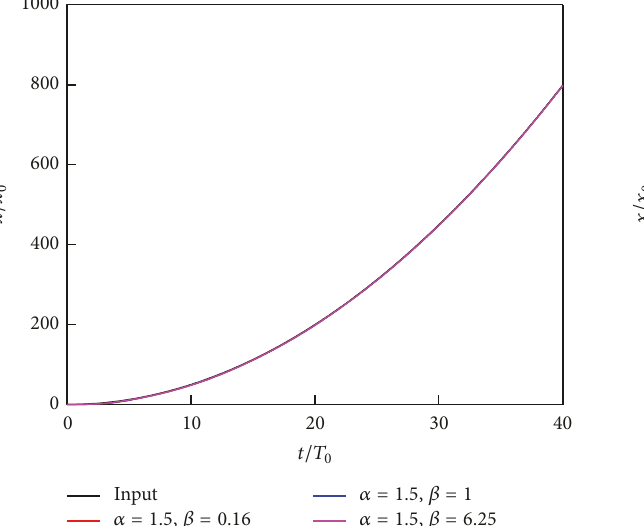
Figure 29: Response in the time domain ( 𝛼 = 1.5, 𝛽 = 0.16, 1, 6.25 ).